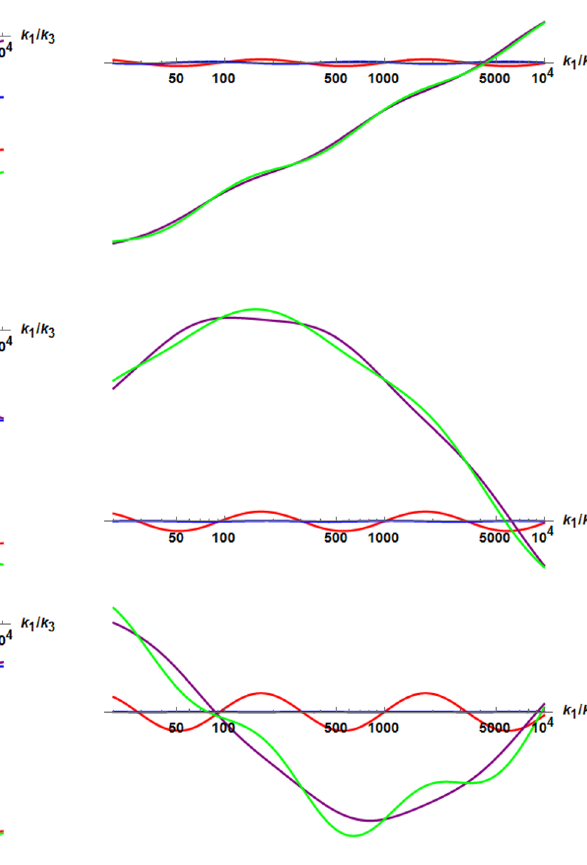
Figure 4 . The same figure with figure 2 but the mixing term S 12 included (purple line). We set ( m ) /H = (2 , 2 . 1) , ( m ) /H = (2 , 2 . 3) , and ( m ) /H = (2 , 2 . 5) from top to 1 , m 2 1 , m 2 1 , m 2